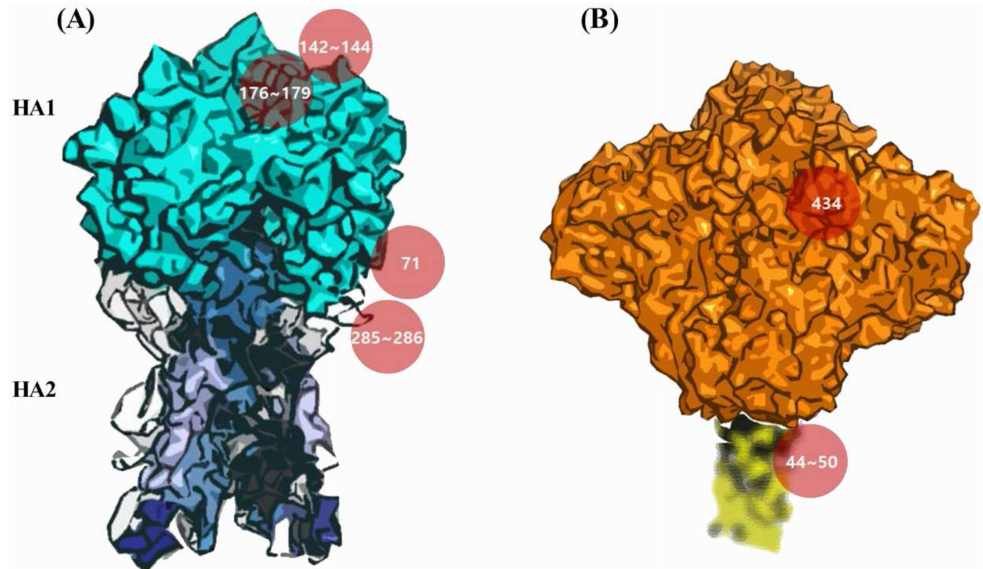
Figure 1. Structures of hemagglutinin (HA) and neuraminidase (NA) with major glycosylation sites. The HA structure ( A ) shows three clusters for pandemic relatedness (red). The positions 142 to 144 (cluster I) and 176 to 179 (cluster II) are located at the top of the HA1. The glycosylations at 285, 286 (cluster III), and 71 are identified on the side of HA. The NA structure ( B ) shows the switch in positions (44 to 50) located in the stem for pandemic status and an independent site (434 in the head domain) for seasonal adaptation (red). The Protein Data Bank (PDB) structure of the stem region (yellow dotted, blurred region) has not been determined yet. The complete absence of glycans in all three clusters of HA coupled with the switch in positions of NA (44 to 50) represent a hallmark of influenza pandemics. The cosegregation of glycosylation positions (HA 71 and NA 434), either the absence or presence at both positions, is identified as an independent characteristic of adaptation to humans and the reverse zoonosis into